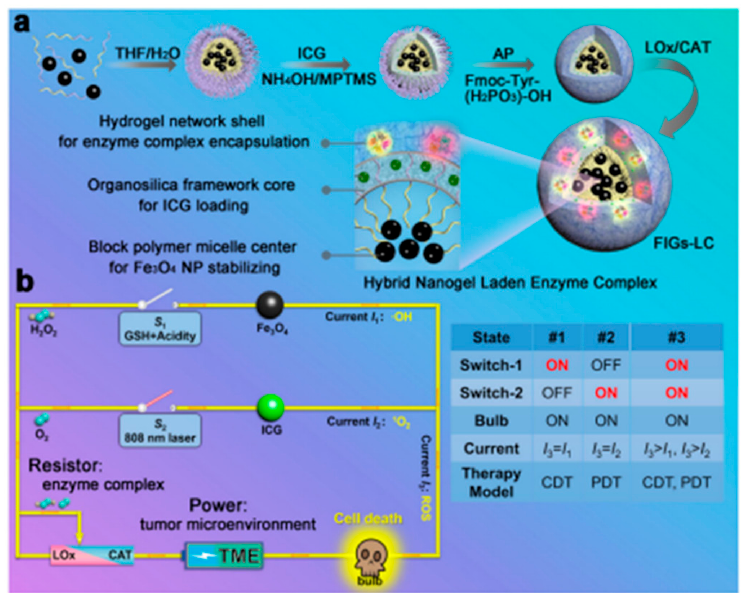
Figure 4. Schematics of synthesis and therapeutic mechanism of FIGs-LC. ( a ) The synthetic procedures of FIGs-LC; ( b ) schematic circuit diagram for the peroxisome-inspired therapeutic mechanism of FIGs-LC based on the dual-enzyme-regulated ROS generation with GSH and NIR activation. Reprinted with permission from Ref. [79]. Copyright 2021, Nature Publishing Group.